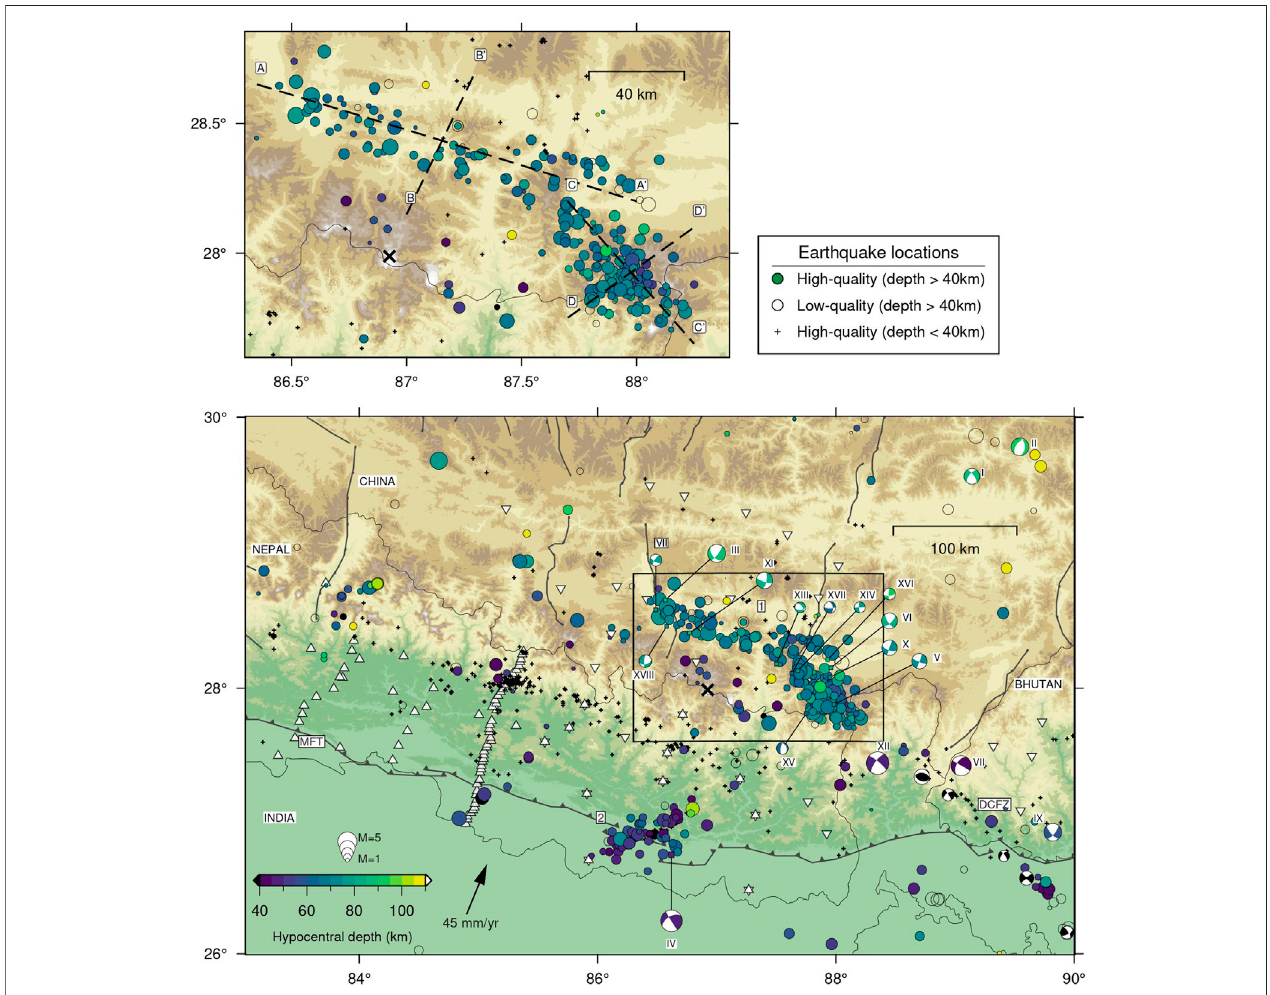
FIGURE2| Epicenters of414relative and absolute earthquake locations calculatedusing HypoDD(Waldhauser, 2001) and NonLinLoc (Lomax et al., 2000) witha 1Dvelocitymodel(Monsalveetal.,2006).Wellconstrainedearthquakelocations(high-quality)areshownbycoloredcirclesscaledbytheirrespectivemagnitudes.Poorly constrained earthquake locations (low-quality) are indicated by empty black circles. Black crosses depict the high-quality shallow seismicity located in this study. The large black cross depicts the location of Mount Everest. MFT is the Main Frontal Thrust and DCFZ is the Dhubri-Chungthang fault zone. Framed numbers 1 and 2 show the seismicity clusters described in the text. Focal mechanisms are the same as in Figure 1 . Inset shows the expanded view of the region marked by the box, focusing on Cluster 1. Black dashed lines with capital letters indicate cross-sections shown in Figures 3 , 4 .